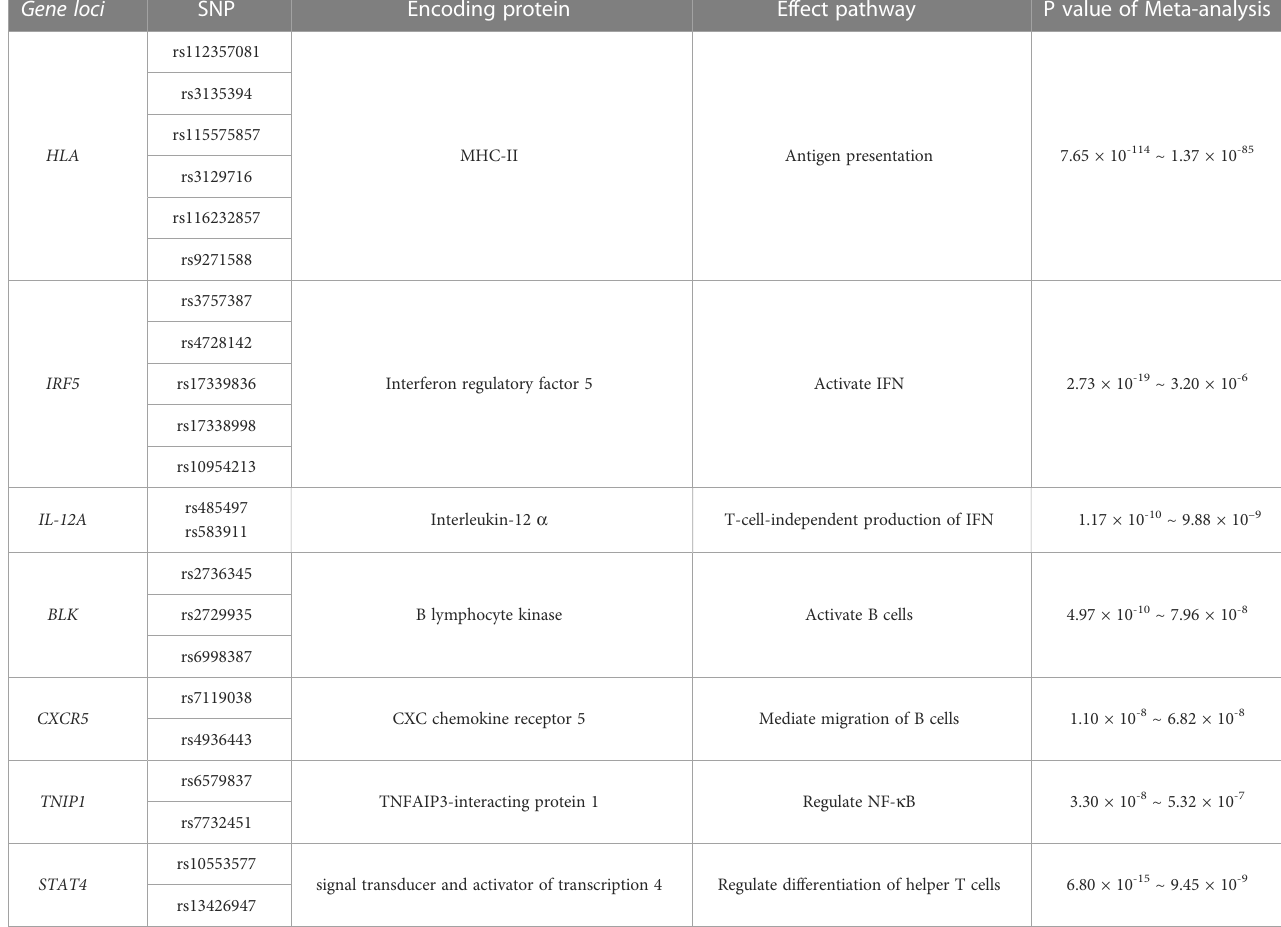
TABLE 1 Genome loci associated with SS. Gene loci SNP Encoding protein Effect pathway P value of